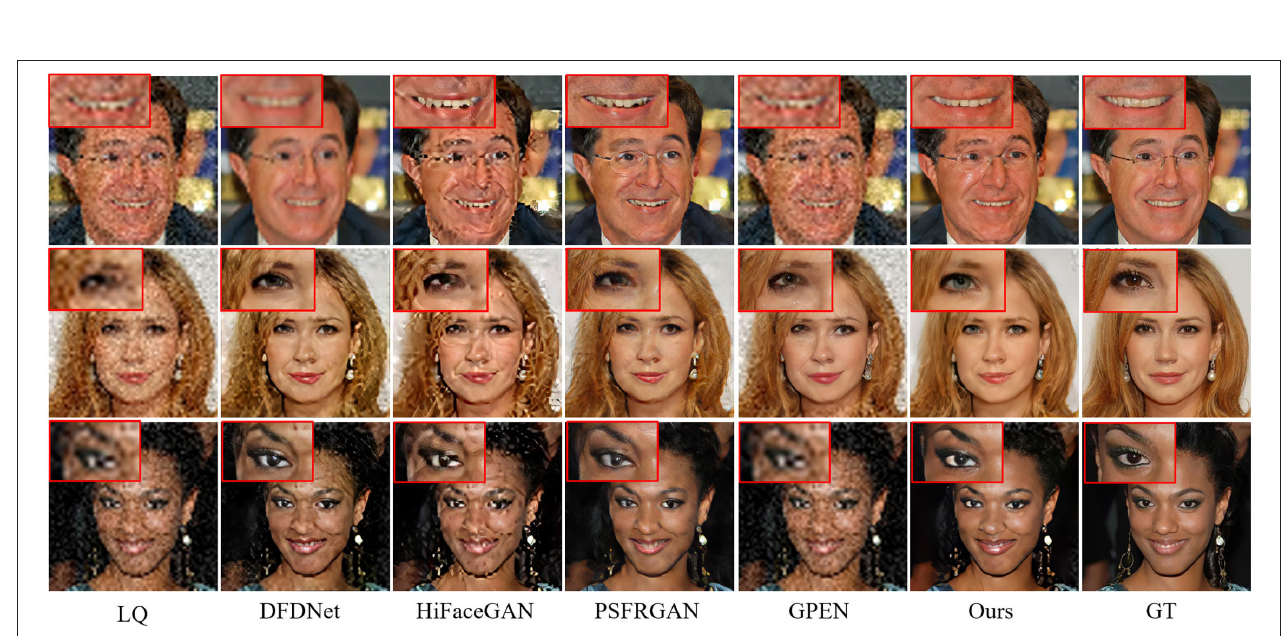
FIGURE 13 | Visual comparison achieved on CelebA-Test with the noise level set at 15.